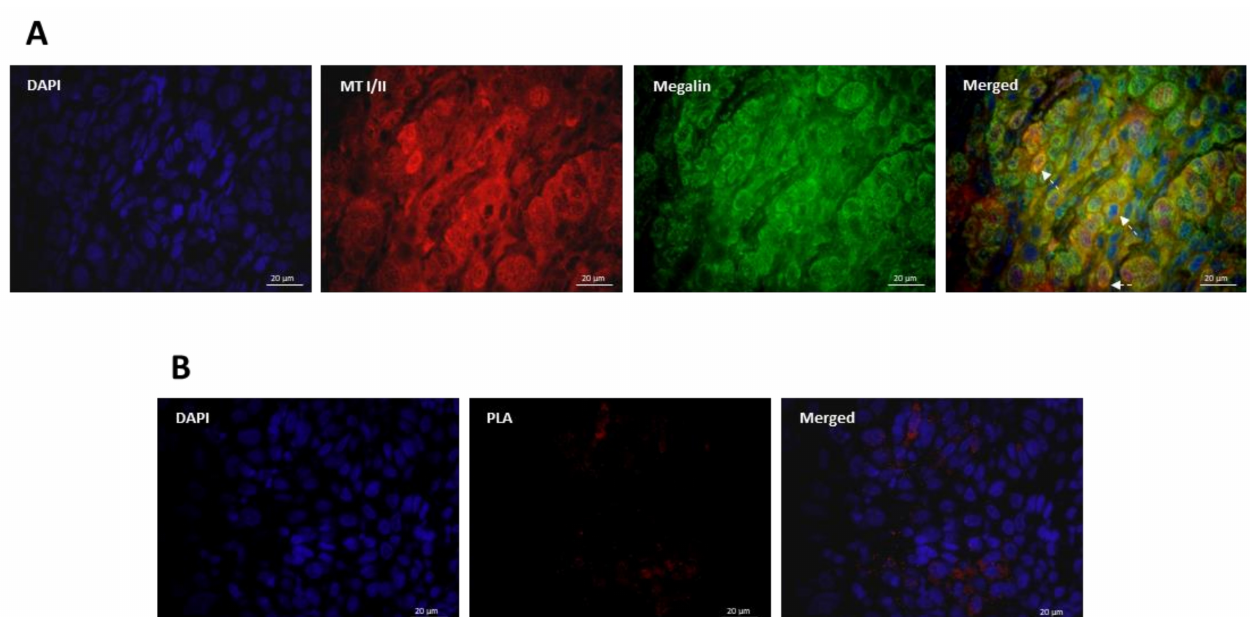
Figure 5. Co-expression and interaction of metallothionein I/II and megalin in oral squamous cell carcinoma. ( A ) Represen- tative photomicrographs of double immunofluorescence staining with anti-MT I/II (red staining) and anti-megalin (green staining) antibodies on paraffin-embedded sections of the OSCC tissue. Blue marks DAPI staining of nuclei. Arrows indicate sites of membrane colocalization. Magnification: × 1000. ( B ) Representative photomicrographs obtained by proximity ligation assay (PLA) on paraffin-embedded sections of the OSCC tissue using anti-MT I/II and anti-megalin antibodies. Red fluorescent signals represent interaction sites. Blue marks DAPI staining of nuclei. Magnification: ×